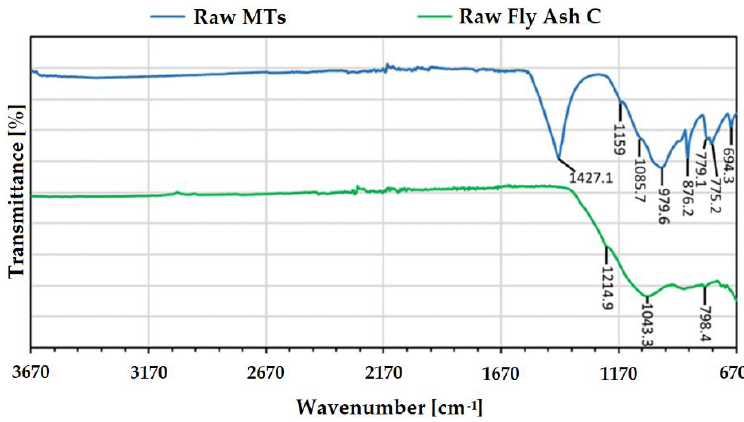
Figure 5. FTIR spectra of the raw FAc and the raw MTs used in this research.